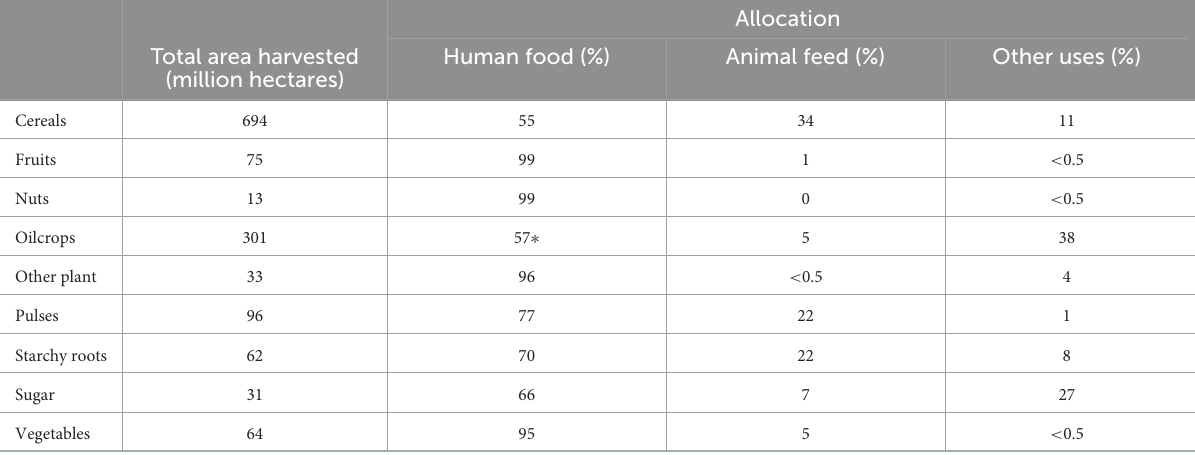
TABLE 2 Allocation of 2018 cropland area harvested to final use.